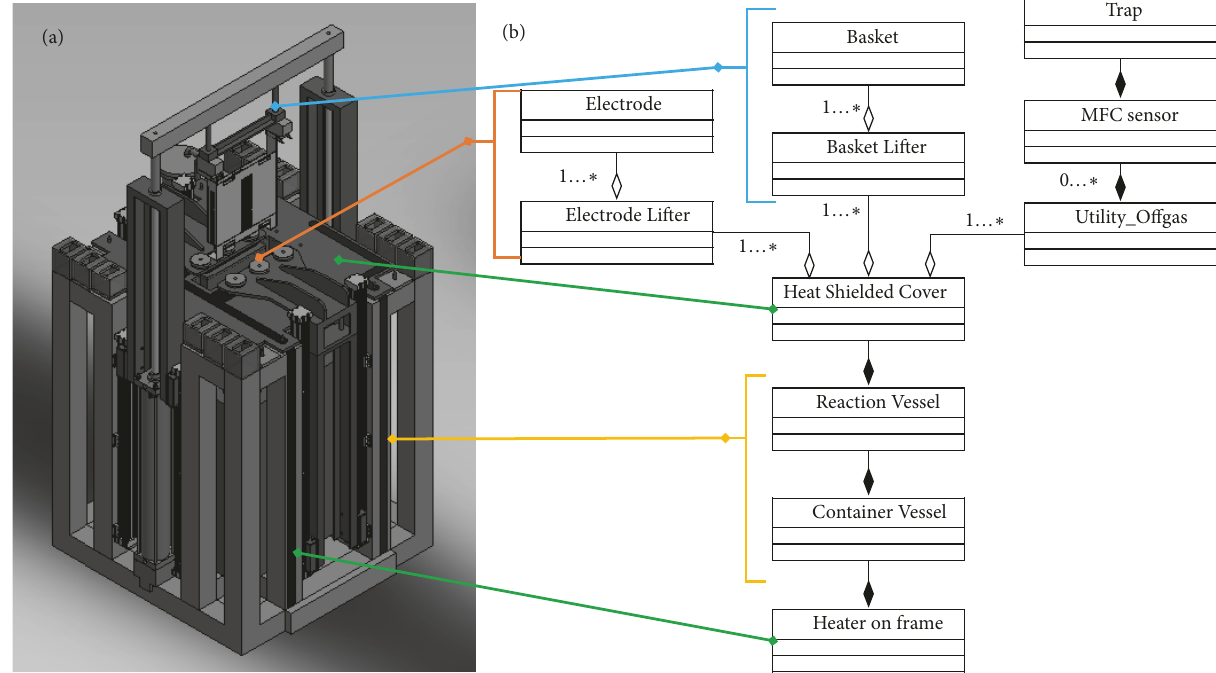
Figure 6: Equipment model. (a) An example of process equipment and (b) UML model.